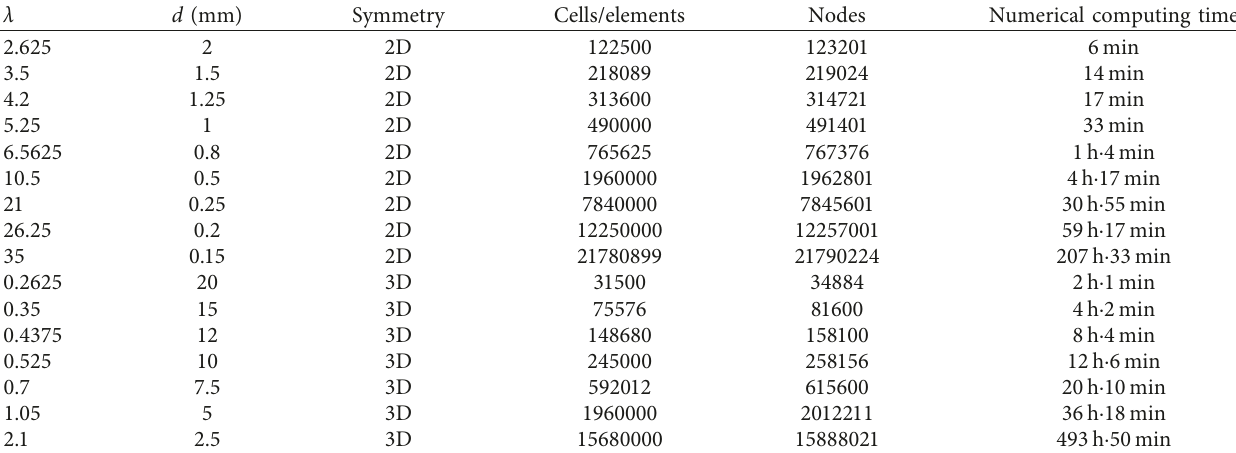
Table 9: The characteristics and calculation time of different mesh size